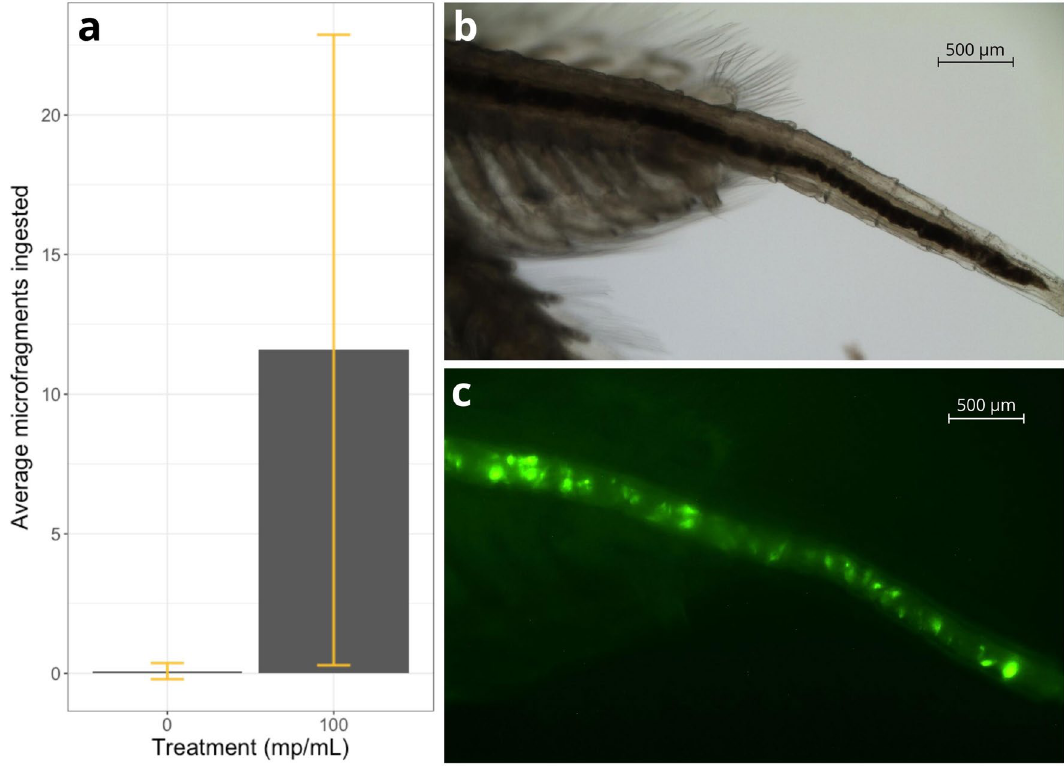
Figure 5. Polyethylene microfragments successfully incorporated into microplastic bioavailability experiment. ( a ) Average number of microfragments ingested per individual in the control (0 mp/mL, n = 12) and experimental (100 mp/mL, n = 24) treatments following the six-hour bioavailability experiment (± one standard deviation). ( b ) Natural light and ( c ) fluorescent micrographs of polyethylene microfragments (53–150 μm) inside the intestinal tract of an adult brine shrimp Artemia sp. with 520–542 μm fluorescent excitation (EVOS FL